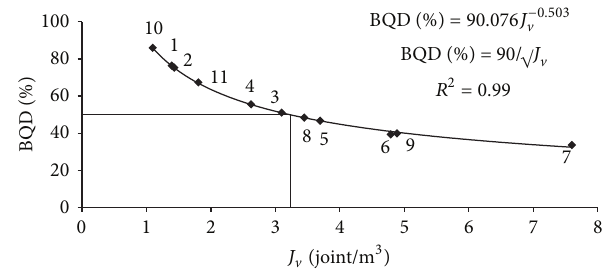
Figure 2: Relation between the rock mass block quality designation (BQD) and the volumetric joint count (𝐽 V ) for the Karaburun limestone